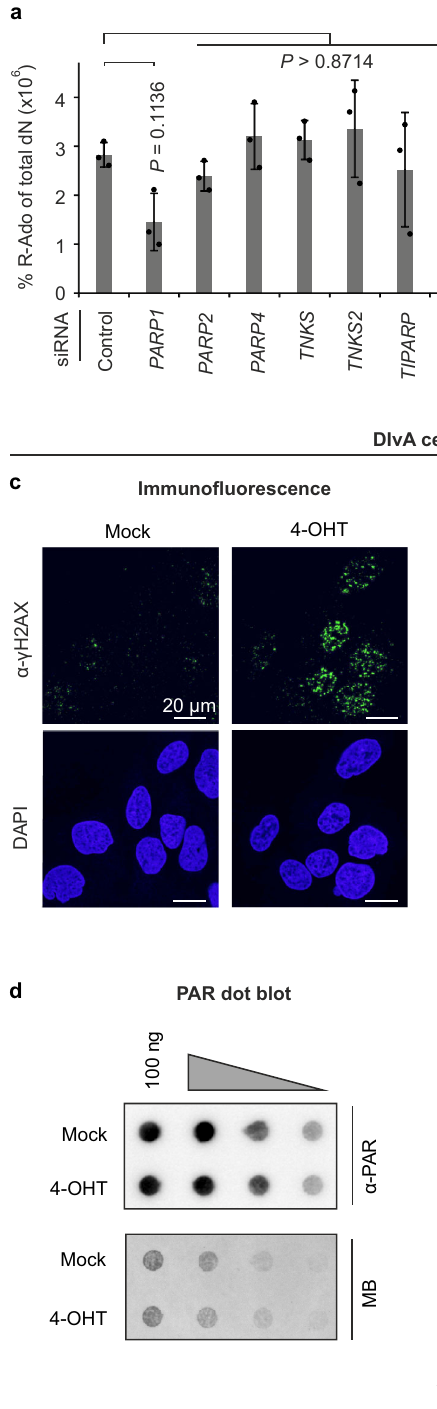
Fig. 2 | DNA PARylation requires PARP1 but is not triggered by strand breaks in vivo. LC-MS/MS quanti fi cation of ribosyladenosine (R-Ado) in 293T ( a ) and mESC( b )DNAaftersiRNAdepletionofselected PARPs .Dataarepresentedasmean values±s.d. of three biological replicates; indicated p values as by two-sided Dunnett ’ s test. c γ H2AX immuno fl uorescence of DIvA cells in which AsiSI nuclease expression was induced by 4-OHT treatment. DNA is stained with DAPI. Immuno- fl uorescence is representative of three independent experiments with similar outcomes. d Dot blot analysis for PARylation of DNA from AsiSI nuclease expres- sing DIvA cells treated as in c with serially diluted (2×) DNA. e Top: γ H2AX ChIP-